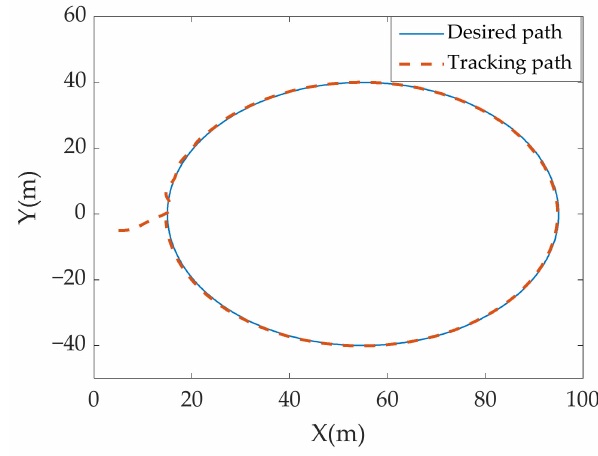
Figure 12. Tracking for circle path.